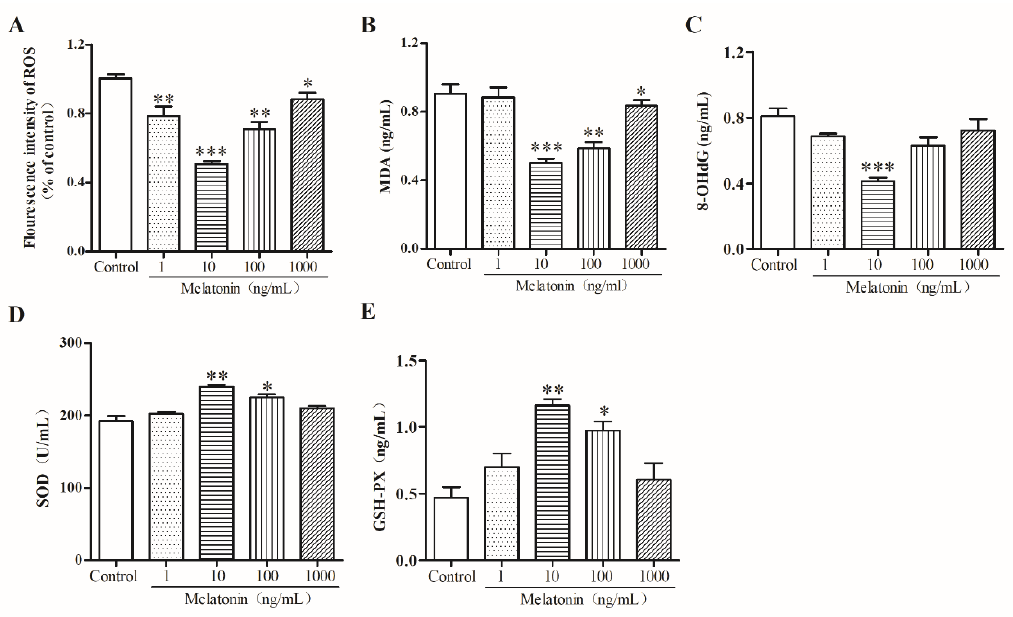
Figure 3. Effects of melatonin on reactive oxygen species (ROS), malondialdehyde (MDA), 8-hydroxy-2′ -deoxyguanosine (8-OHdG), superoxide dismutase (SOD), and glutathione peroxidase (GSH-Px) in mouse Leydig cells. ( A ) The fluorescence intensity of ROS was measured by flow cytometry analysis ( n = 3). The levels of MDA ( B ), 8-OHdG ( C ), SOD ( D ) and GSH-Px ( E ) were measured by a microplate reader ( n = 3). Values are shown as mean ± SEM. *** p < 0.001, ** p < 0.01 or * p < 0.05 compared with the control group.